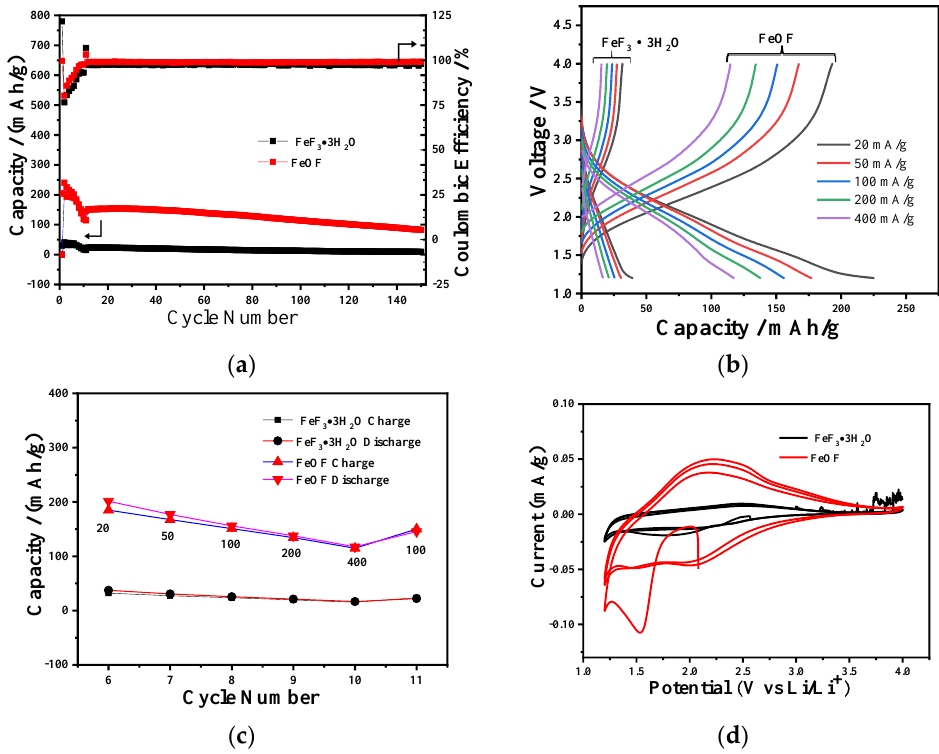
Figure 5. ( a ) Coulombic efficiency and cycling performance. ( b ) The charge/discharge profiles at different current rates. ( c ) Charge/discharge capacities at different current rates. ( d ) CV curves at 1.2 – 4.0 V. Table 3. Comparisons of the electrochemical performances for different bare FeOF as cathode material for SIBs.